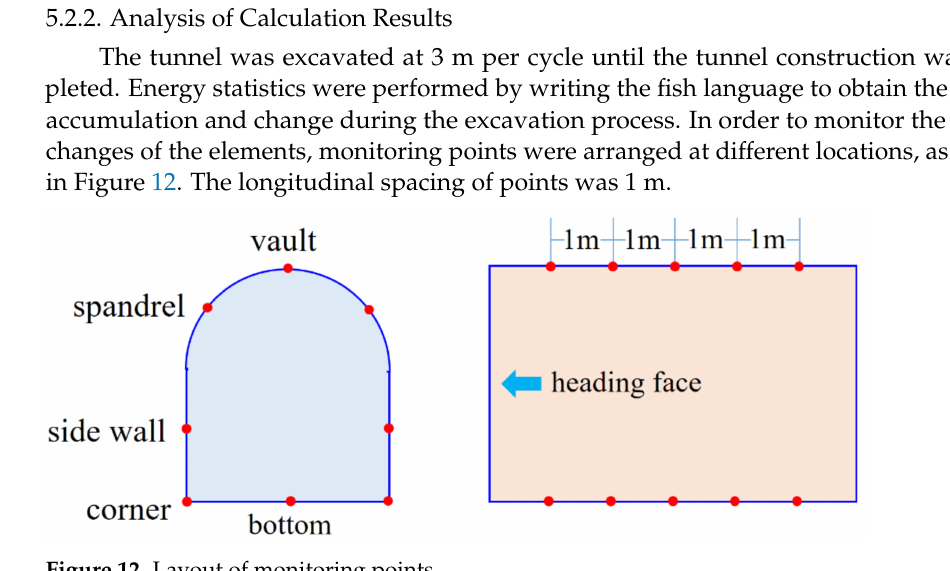
Figure 12. Layout of monitoring